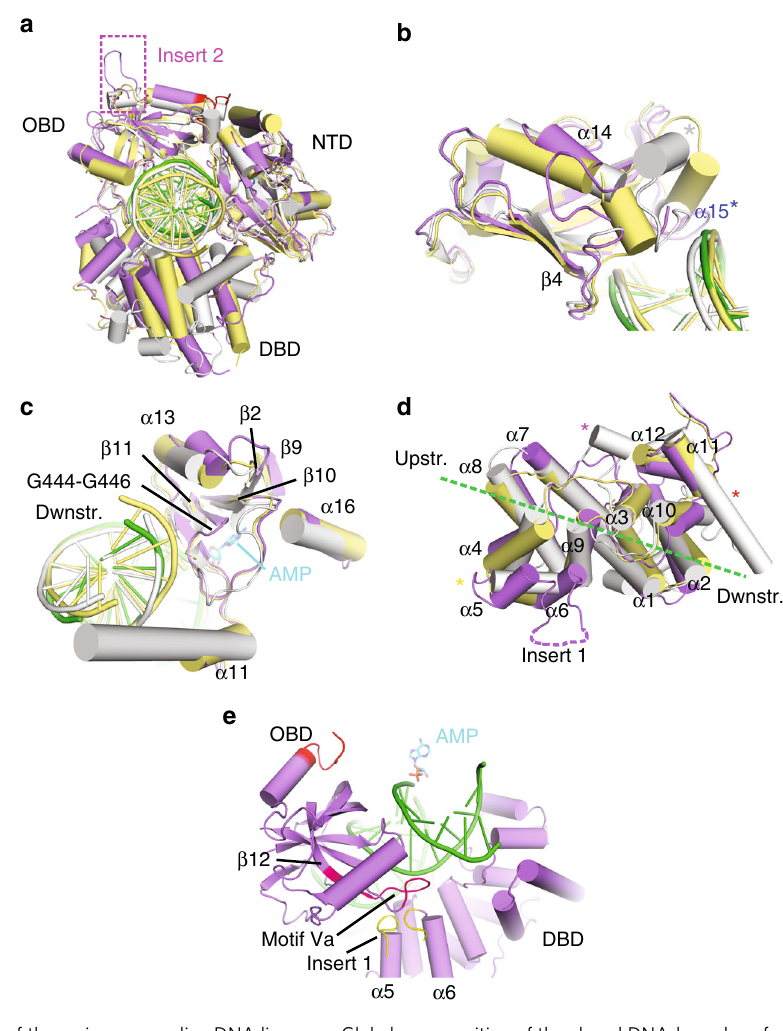
Fig. 7 Structural comparison of the major mammalian DNA ligases. a Global superposition of the closed DNA-bound conformations of LigIV (purple, DNA in green), LigI (gray, PDB ID code 1X9N 19 ), and LigIII (khaki, PDB ID code 3L2P 18 ). Structural differences in the NTD ( b ), OBD ( c ), and DBD ( d ) subdomains of the mammalian ligases (DNA binding path in green). e Regions of interest in LigIV that contribute to its unique biological behaviors. Labels for secondary structural elements are representative of LigIV (numbered as in Supplementary Fig 3). Structurally disparate motifs are marked by asterisks, as follows: blue asterisk, α -helix that is conserved in LigI and LigIII structures, but is disordered ( α 15) in the DNA-bound structure of LigIV; gray, short α -helix present only in LigI (Asp647-Ile651); red asterisk, α 11 is considerably longer in LigI than in LigIV; magenta asterisk, short helix present only in LigI (Pro341-Gly344); yellow asterisk, α 5- α 6 and Insert 1 regions in LigIV are dissimilar to the equivalent region in LigI and